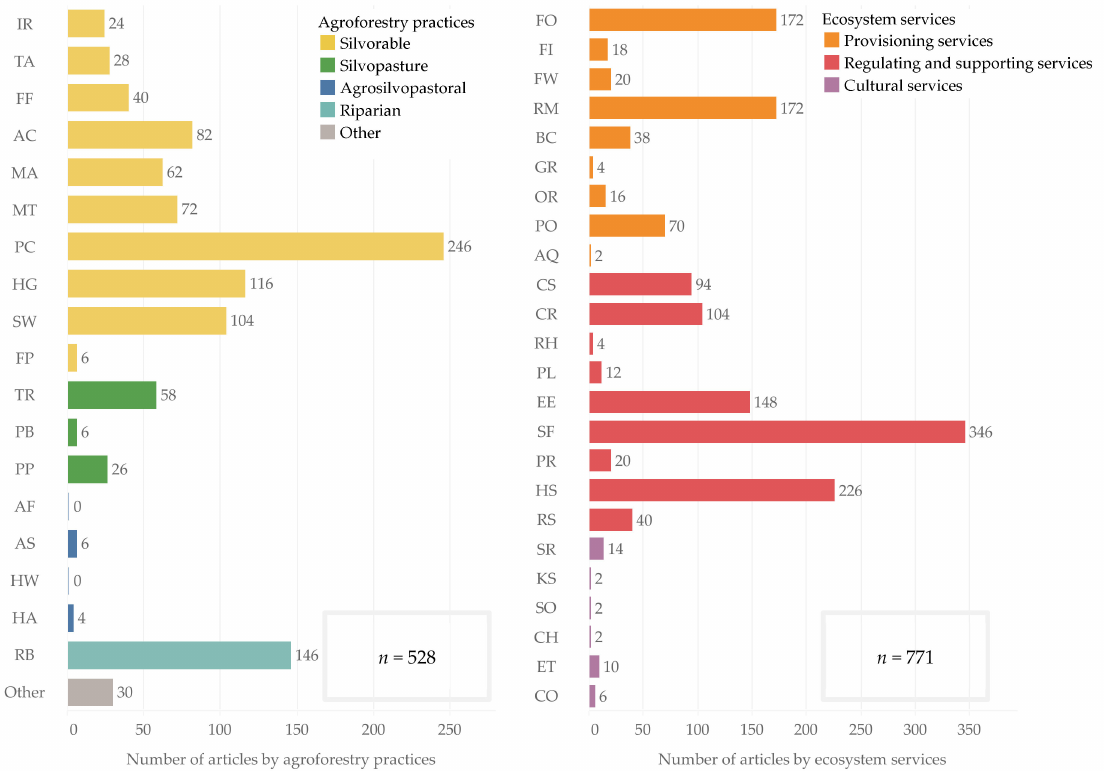
Figure 4. The number of articles by agroforestry practices and ecosystem